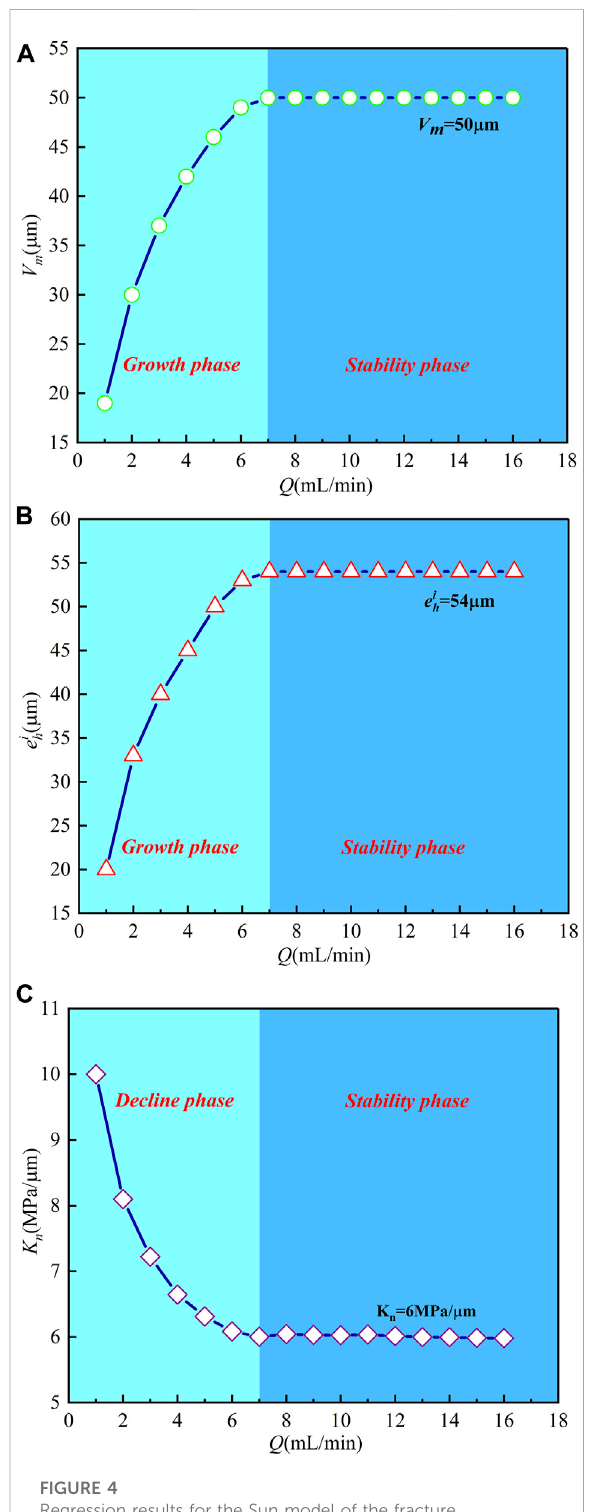
FIGURE 4 Regression results for the Sun model of the fracture deformation constitutive law. (A) Maximum hydraulic aperture closure deformation V m and fl ow rate Q , (B) initial hydraulic aperture e h i and fl ow rate Q , and (C) normal stiffness of the fracture K n and fl ow rate